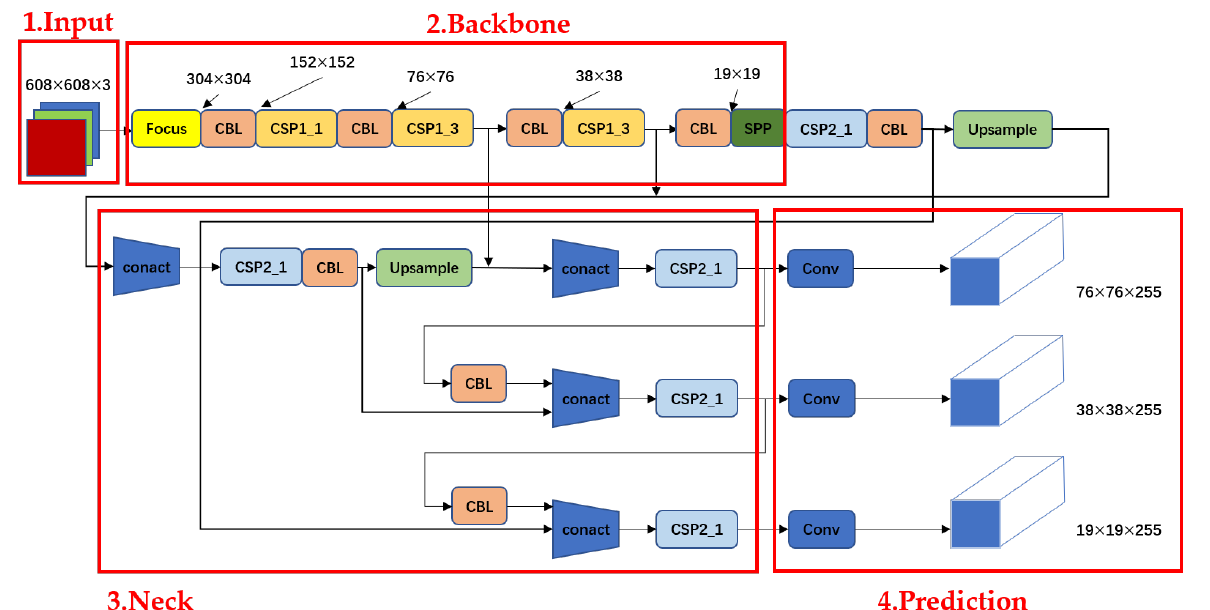
Figure 4. The network structure of YOLOv5, which is composed of the input module, backbone network, neck network, and prediction network. (CSP: Cross Stage Partial Network; SPP: Spatial Pyramid Pooling; Conv: Convolutional Layer; Concat: Concatenate Function).